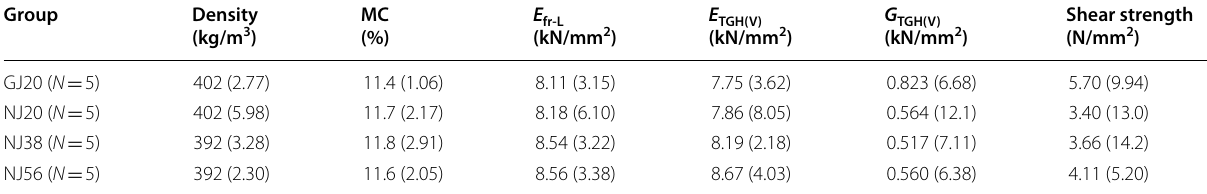
The left and right values in the cell are the mean value and CV (in percentage). In the case of bending failure, shear strength was calculated using the load during bending failure as the apparent shear failure N, number of specimens; MC, moisture content; E fr-L , Young’s modulus by the longitudinal vibration method; E TGH(V) ,Young’s modulus by the Timoshenko–Goens– Hearmon flexural vibration method (TGH method); G TGH(V) , shear modulus by the TGH method